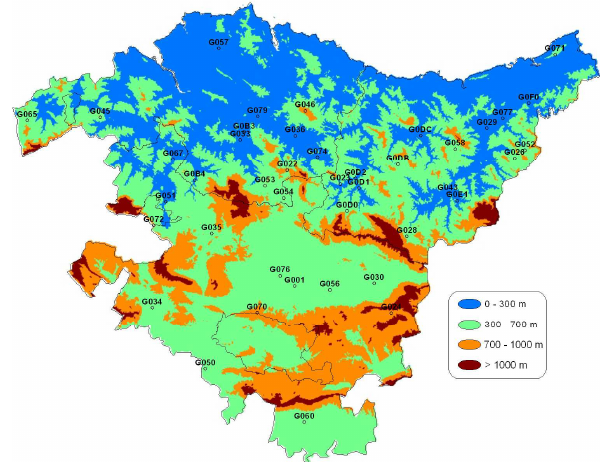
Figure 3. Wind warning areas and wind sensor distribution. 2